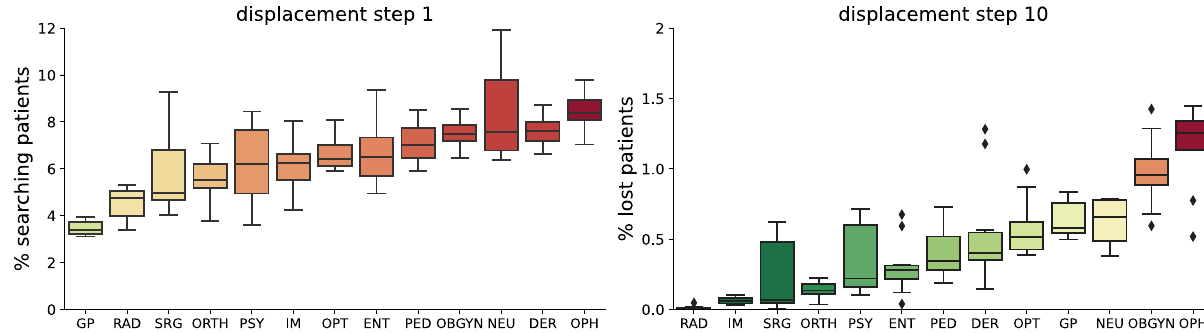
Fig. 6 Impact of a large-scale unavailability event on searching and lost patients. Percentage of patients looking for a new physician for each specialty one and ten displacement steps after a large shock where 15% of physicians of a given specialty were removed from the network. Patients who remain searching after 10 timesteps become lost. Boxes show the quartiles of the data set of an ensemble of 10 simulation runs, whiskers show the rest of the distribution. Points over 1.5 of the inter-quartile range past the high and low quartiles are considered outliers and shown as individual points. For a list of abbreviations of specialists see Table